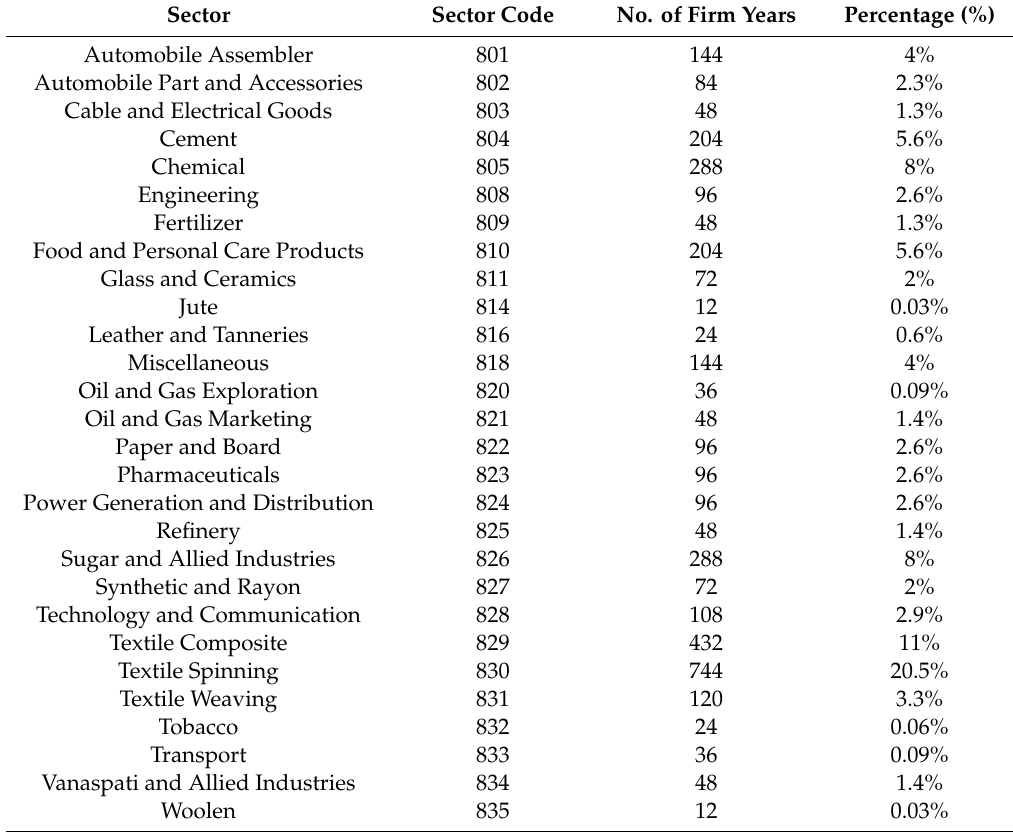
Table 1. Industry classification of